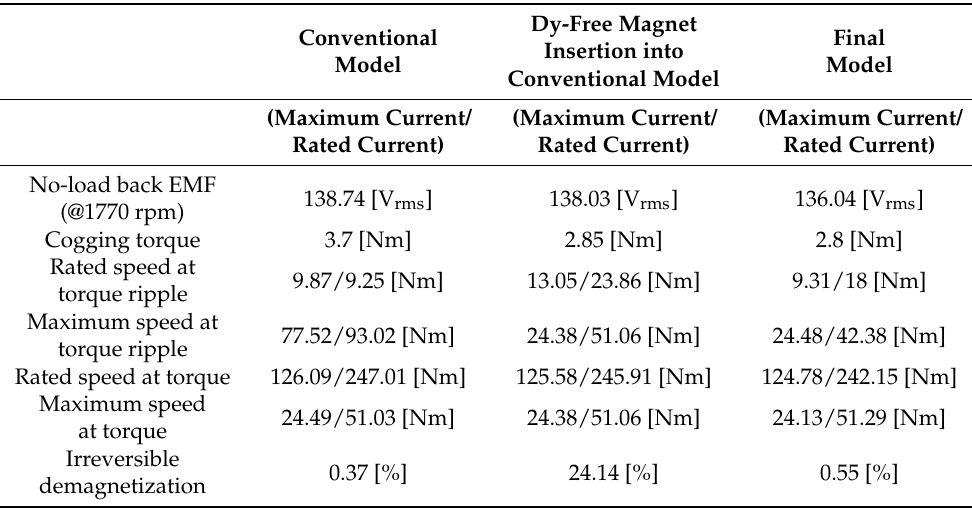
Table 2. Comparative analysis of the electromagnetic performance of the conventional model that used the NDFEB magnet and the final model that used the Dy-free NDFEB magnet.